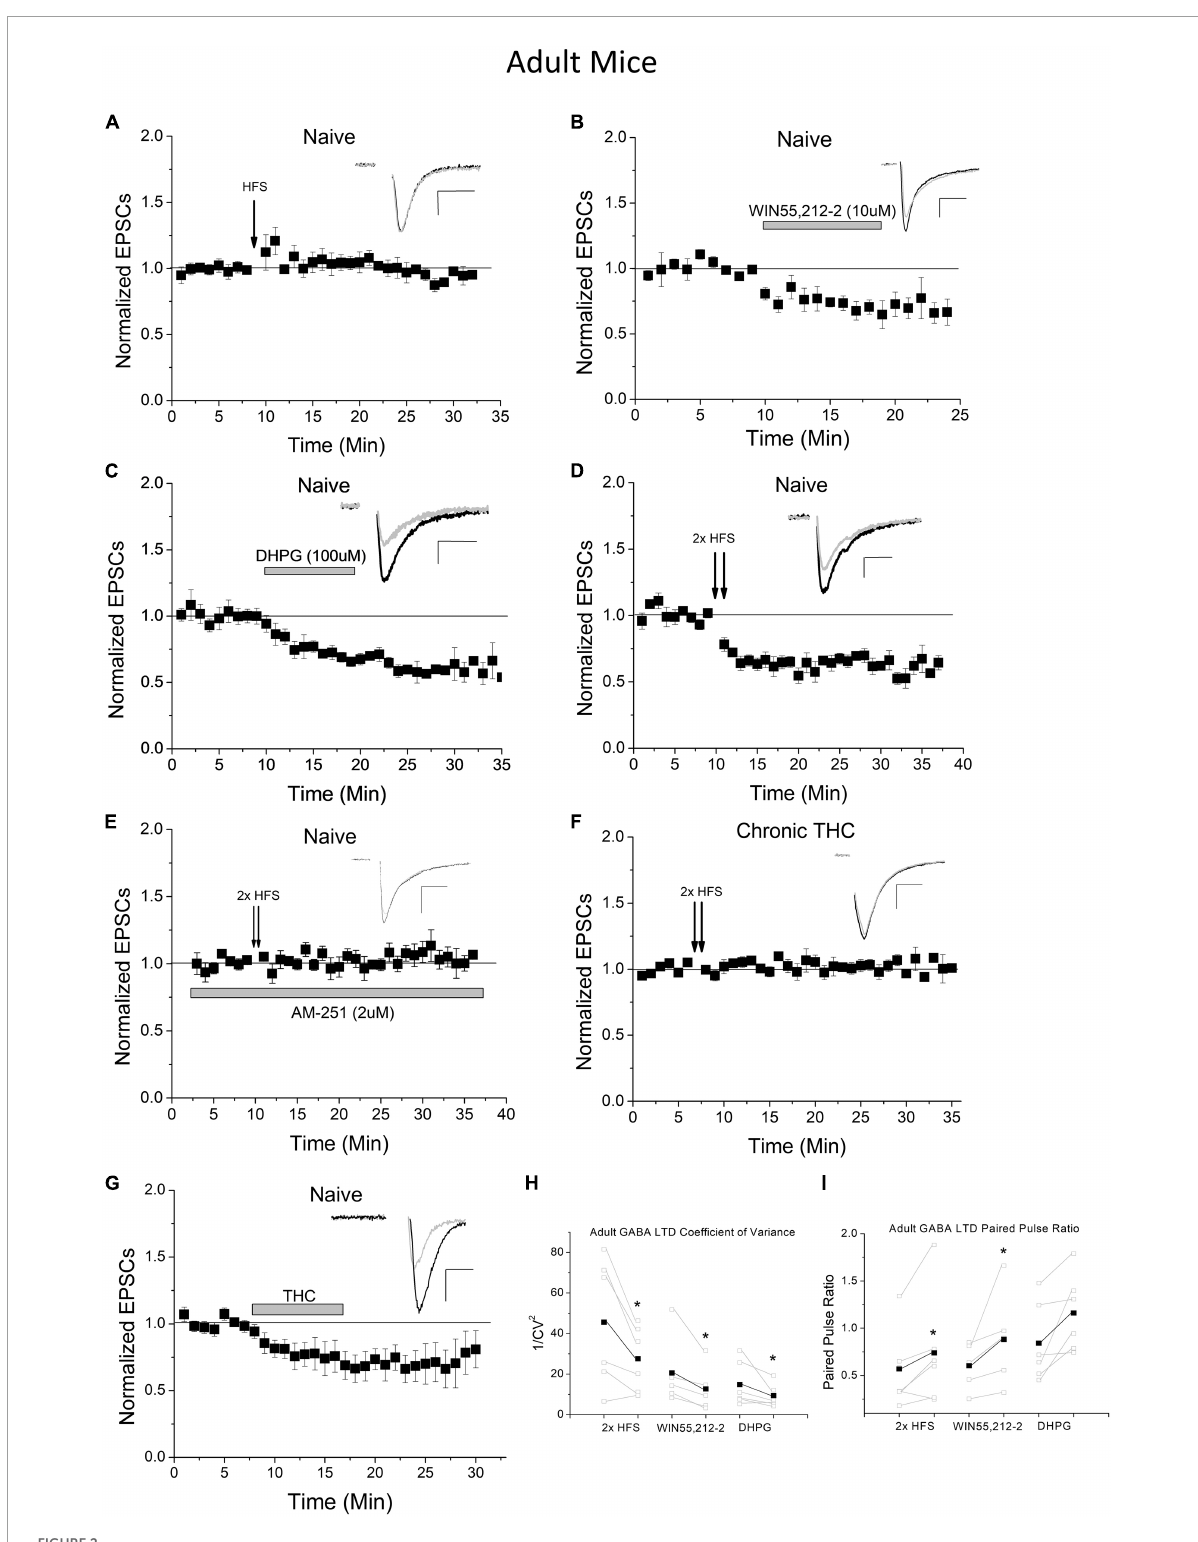
FIGURE2 Adult mice exhibit increased LTD induction thresholds of excitatory inputs to VTA GABA neurons. (A) HFS does not induce LTD in adult mice compared to baseline (1.4 ± 5.7%, n = 8, p > 0.1, P70-150) and is significantly different than HFS young mice at the same time points compared to Figure 1A ( p < 0.001). (B) WIN55,212-2 significantly depresses excitatory currents in adult mice compared to baseline (by 31.0 ± 10.1%; n = 5,